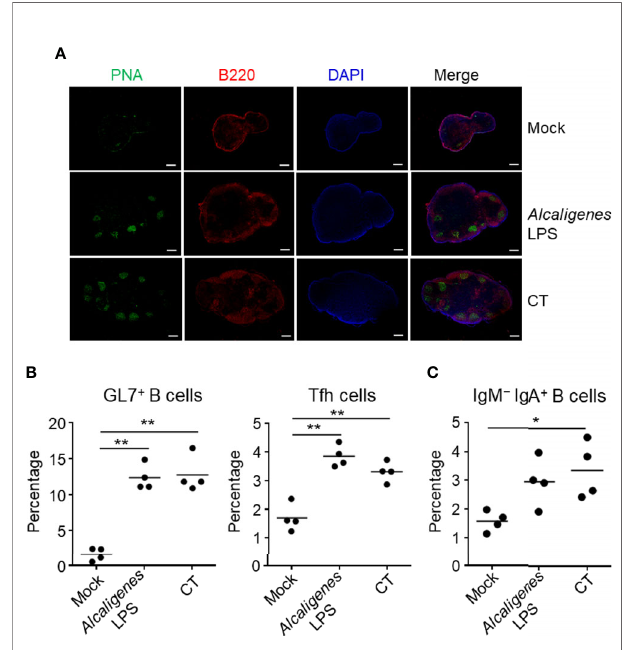
FIGURE 2 | Alcaligenes LPS induces germinal center formation in CLNs. Mice were nasally immunized three times with OVA alone (Mock) or with OVA plus Alcaligenes LPS or CT; one week after the fi nal immunization, GC formation (A) , and the induction of GC GL7 + B cells (gated on: CD3 ϵ − B220 + GL7 + ) and Tfh cells (gated on: CD3 ϵ + CD8 a − CD4 + PD-1 + ) (B) and of IgM − IgA + B cells (gated on: CD3 ϵ − B220 + GL7 + IgM − IgA + ) (C) in CLNs were examined by fl ow cytometry. ( n = 4 per group). Data are representative of two independent experiments and were analyzed by one-way ANOVA (* p < 0.05; ** p < 0.01).